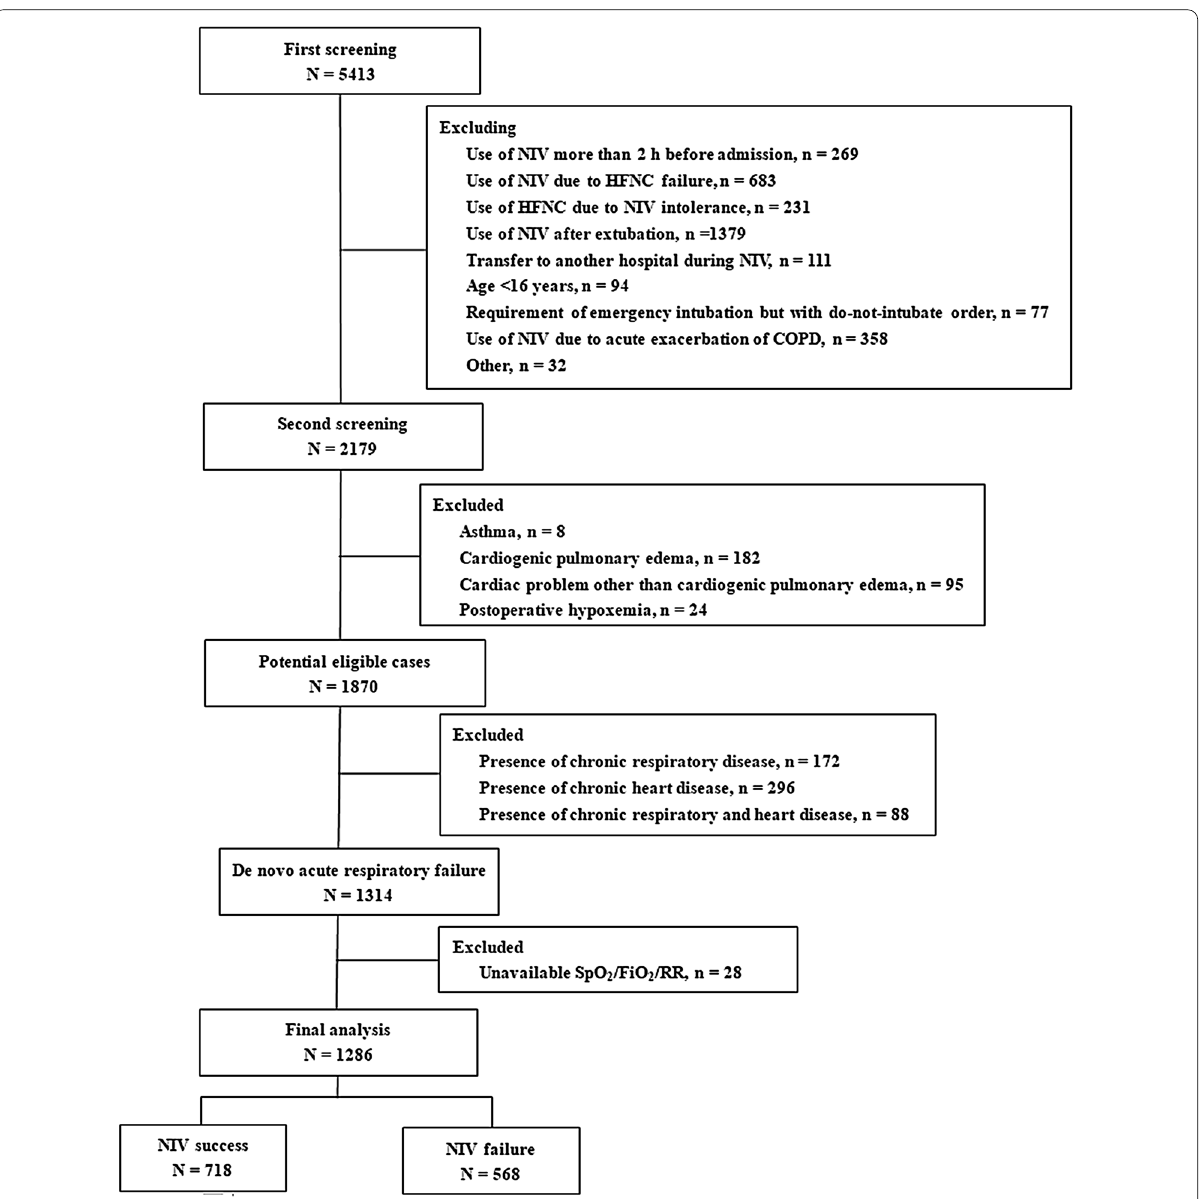
Fig. 1 Patient screening. HFNC high-flow nasal cannula, NIV noninvasive ventilation, RR respiratory